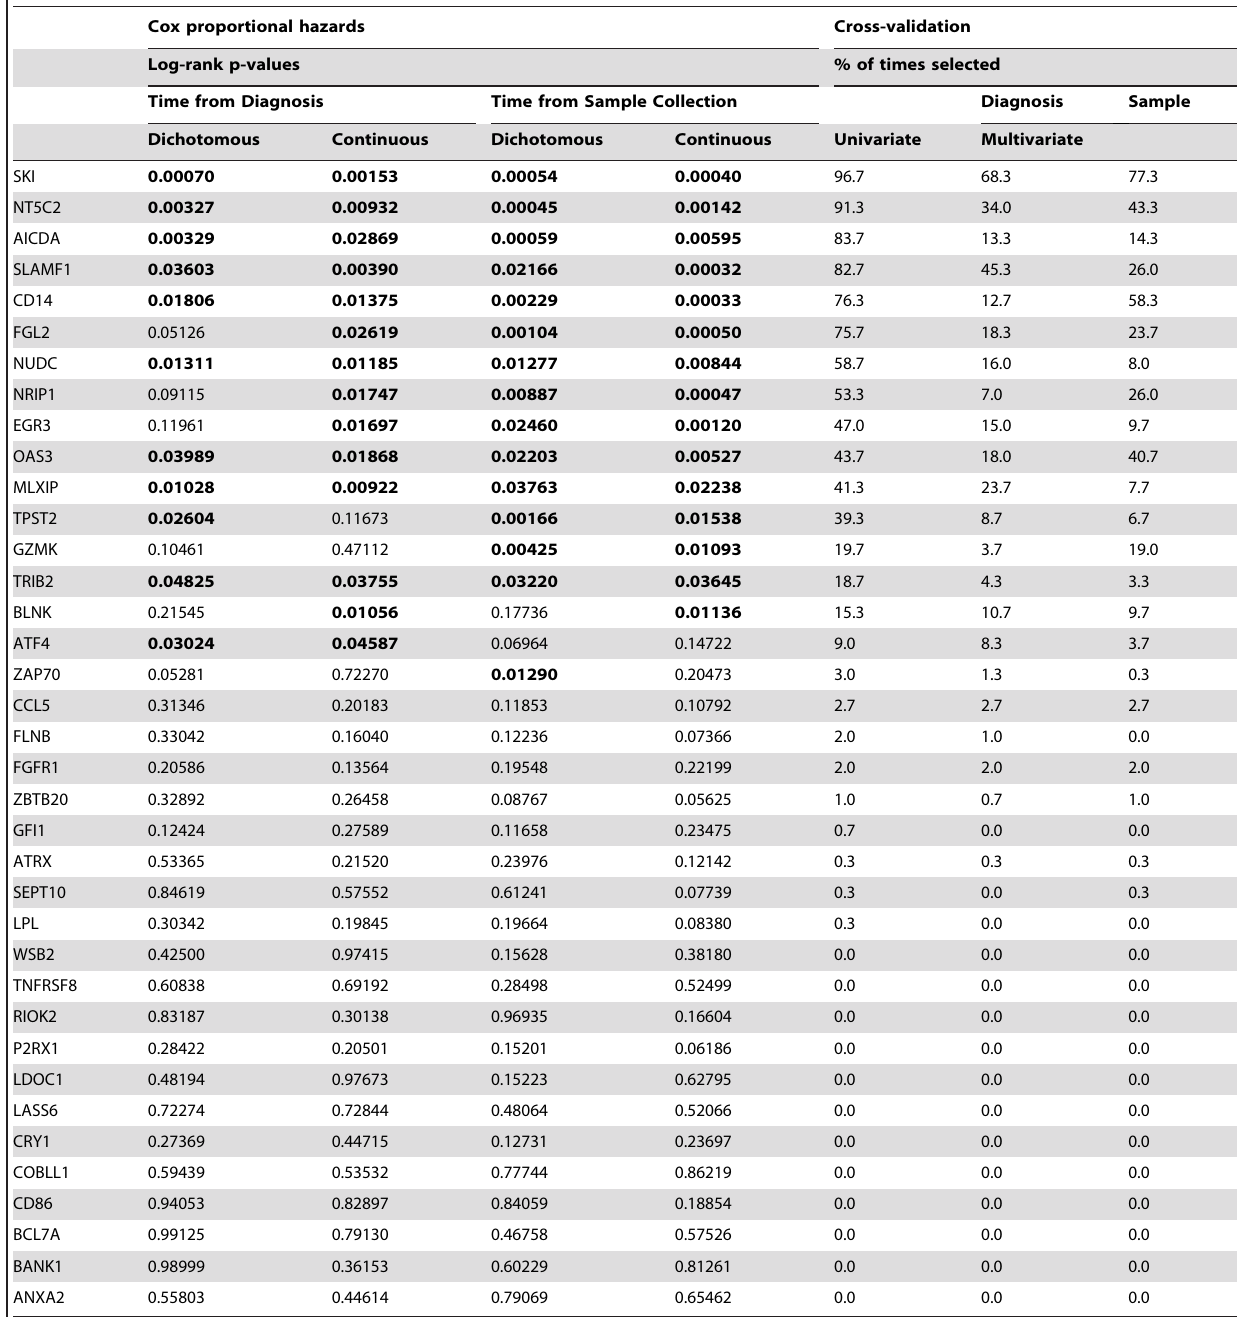
Table 2. Ability of genes to predict time-to-treatment on the training